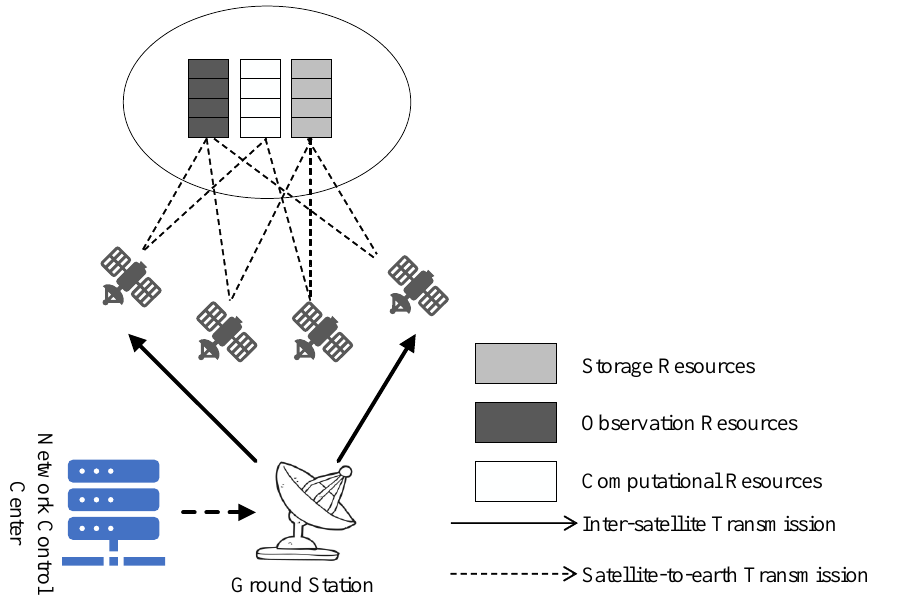
Figure 1. Schematic diagram of the existing spatial information network resource scheduling